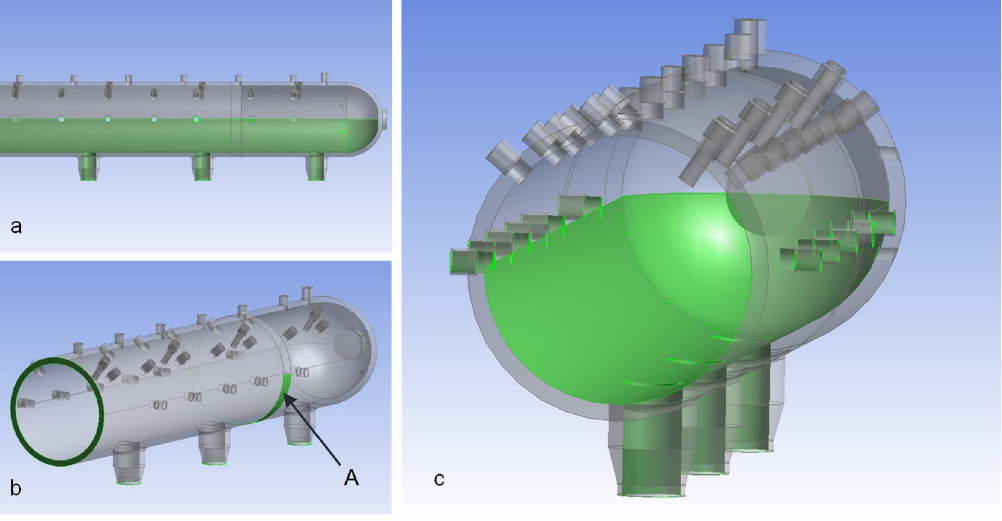
Figure 4. Multiple perspectives of the 3D drum model. Front view of the right part of the drum with the water level marked ( a ). Perspective view with the plane of symmetry in the cross-section and the area of influence of the suspensions marked with the letter A ( b ). Perspective view from the left front side of the drum ( c ).